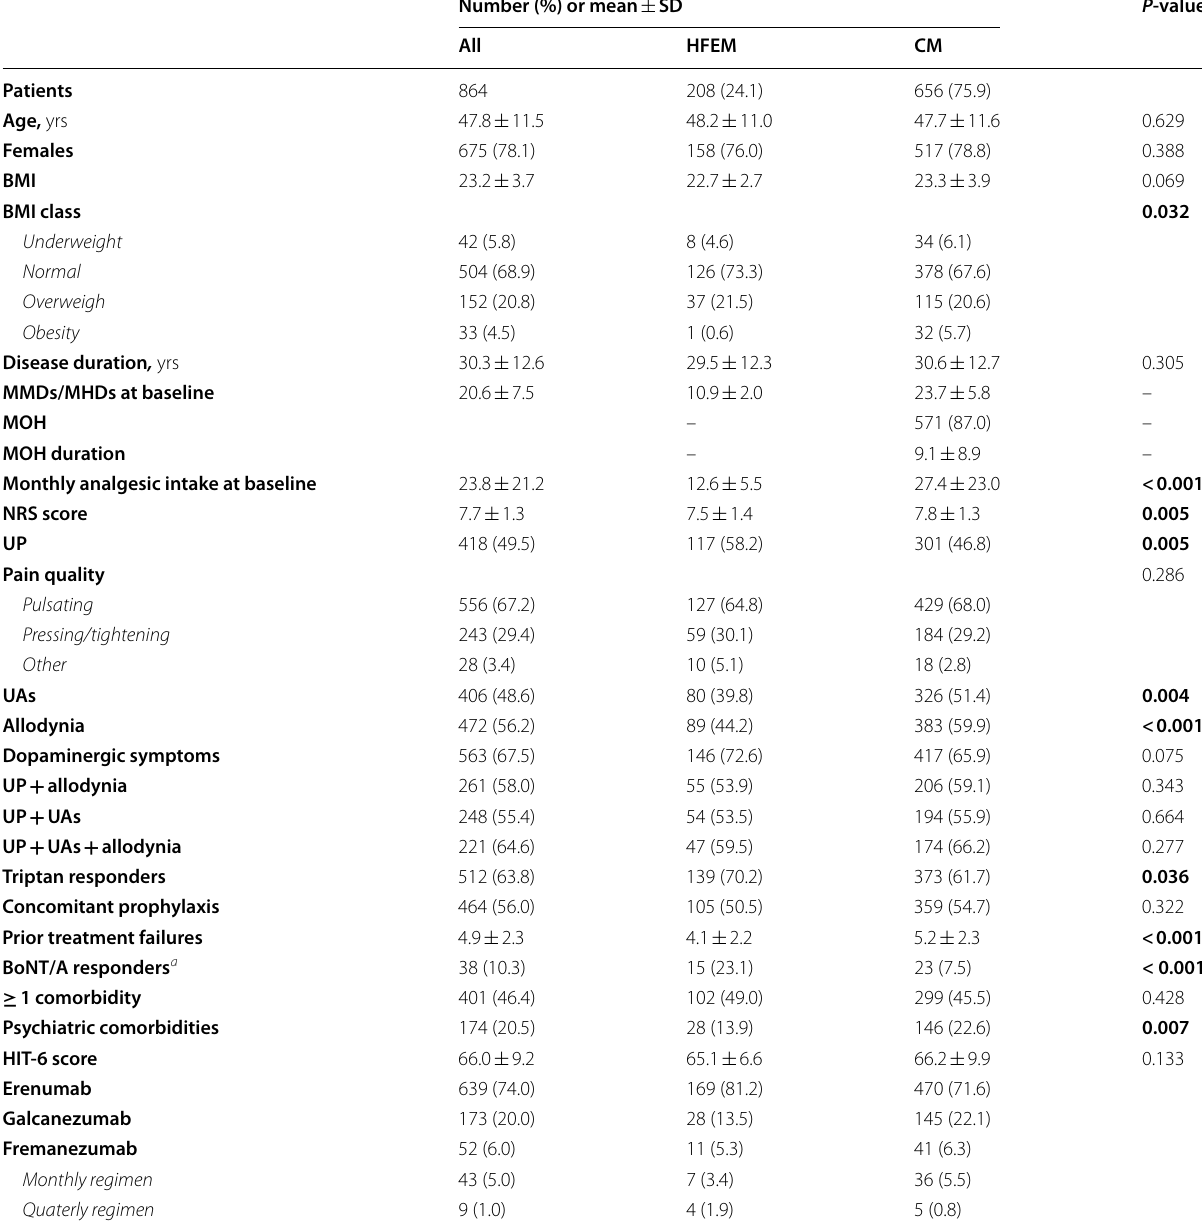
Table 1 Demographic and clinical features of migraine patients by high-frequency episodic (HFEM) or chronic migraine